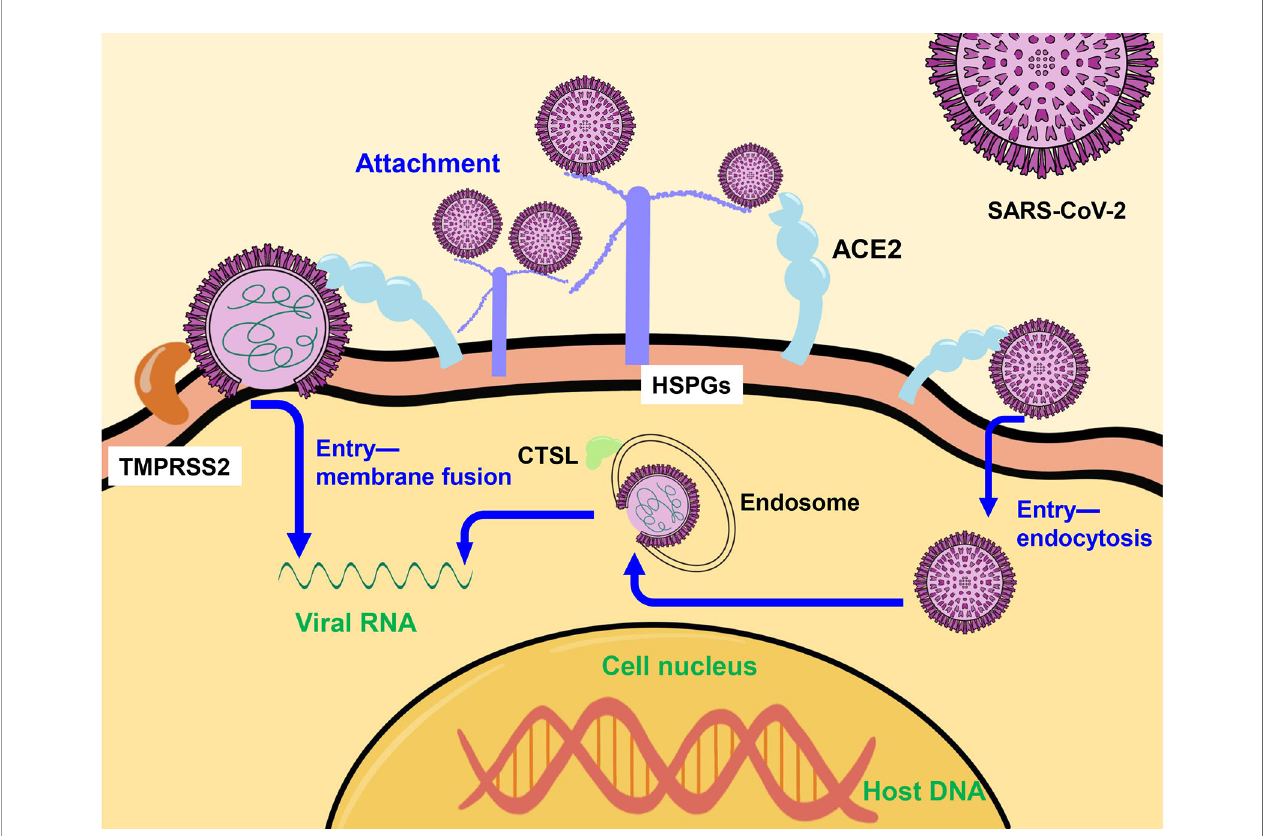
FIGURE 1 | The mechanism of SARS-CoV-2 entry into the host cell. SARS-CoV-2 enters into cells by membrane fusion-mediated with the assistance of TMPRSS2 or via the endocytosis route to form endosome, and release genomic RNA into cytoplasm directly with the assistance of CTSL. TMPRSS2, transmembrane protease serines 2; CTSL, cathepsin